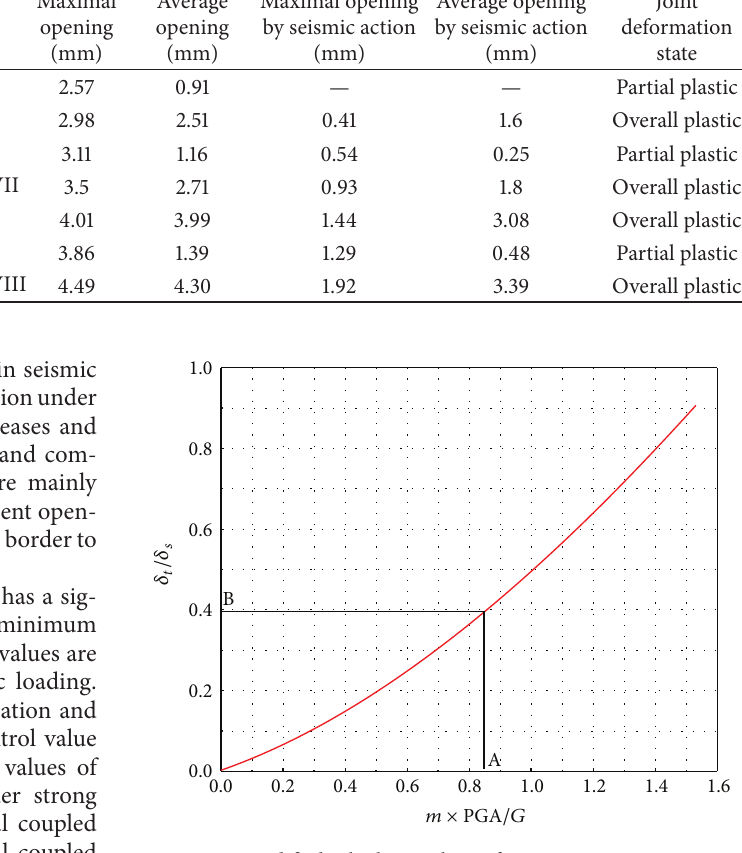
Figure 10: Modified calculating chart of segment opening owing to seismic